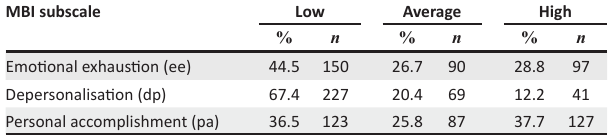
TABLE 4: The participants’ scores on the three components of the Maslach Burnout Inventory.